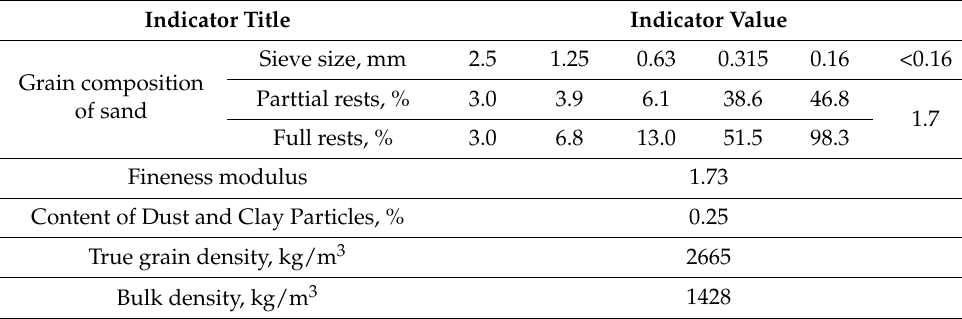
Table 4. Properties of the quartz sand.